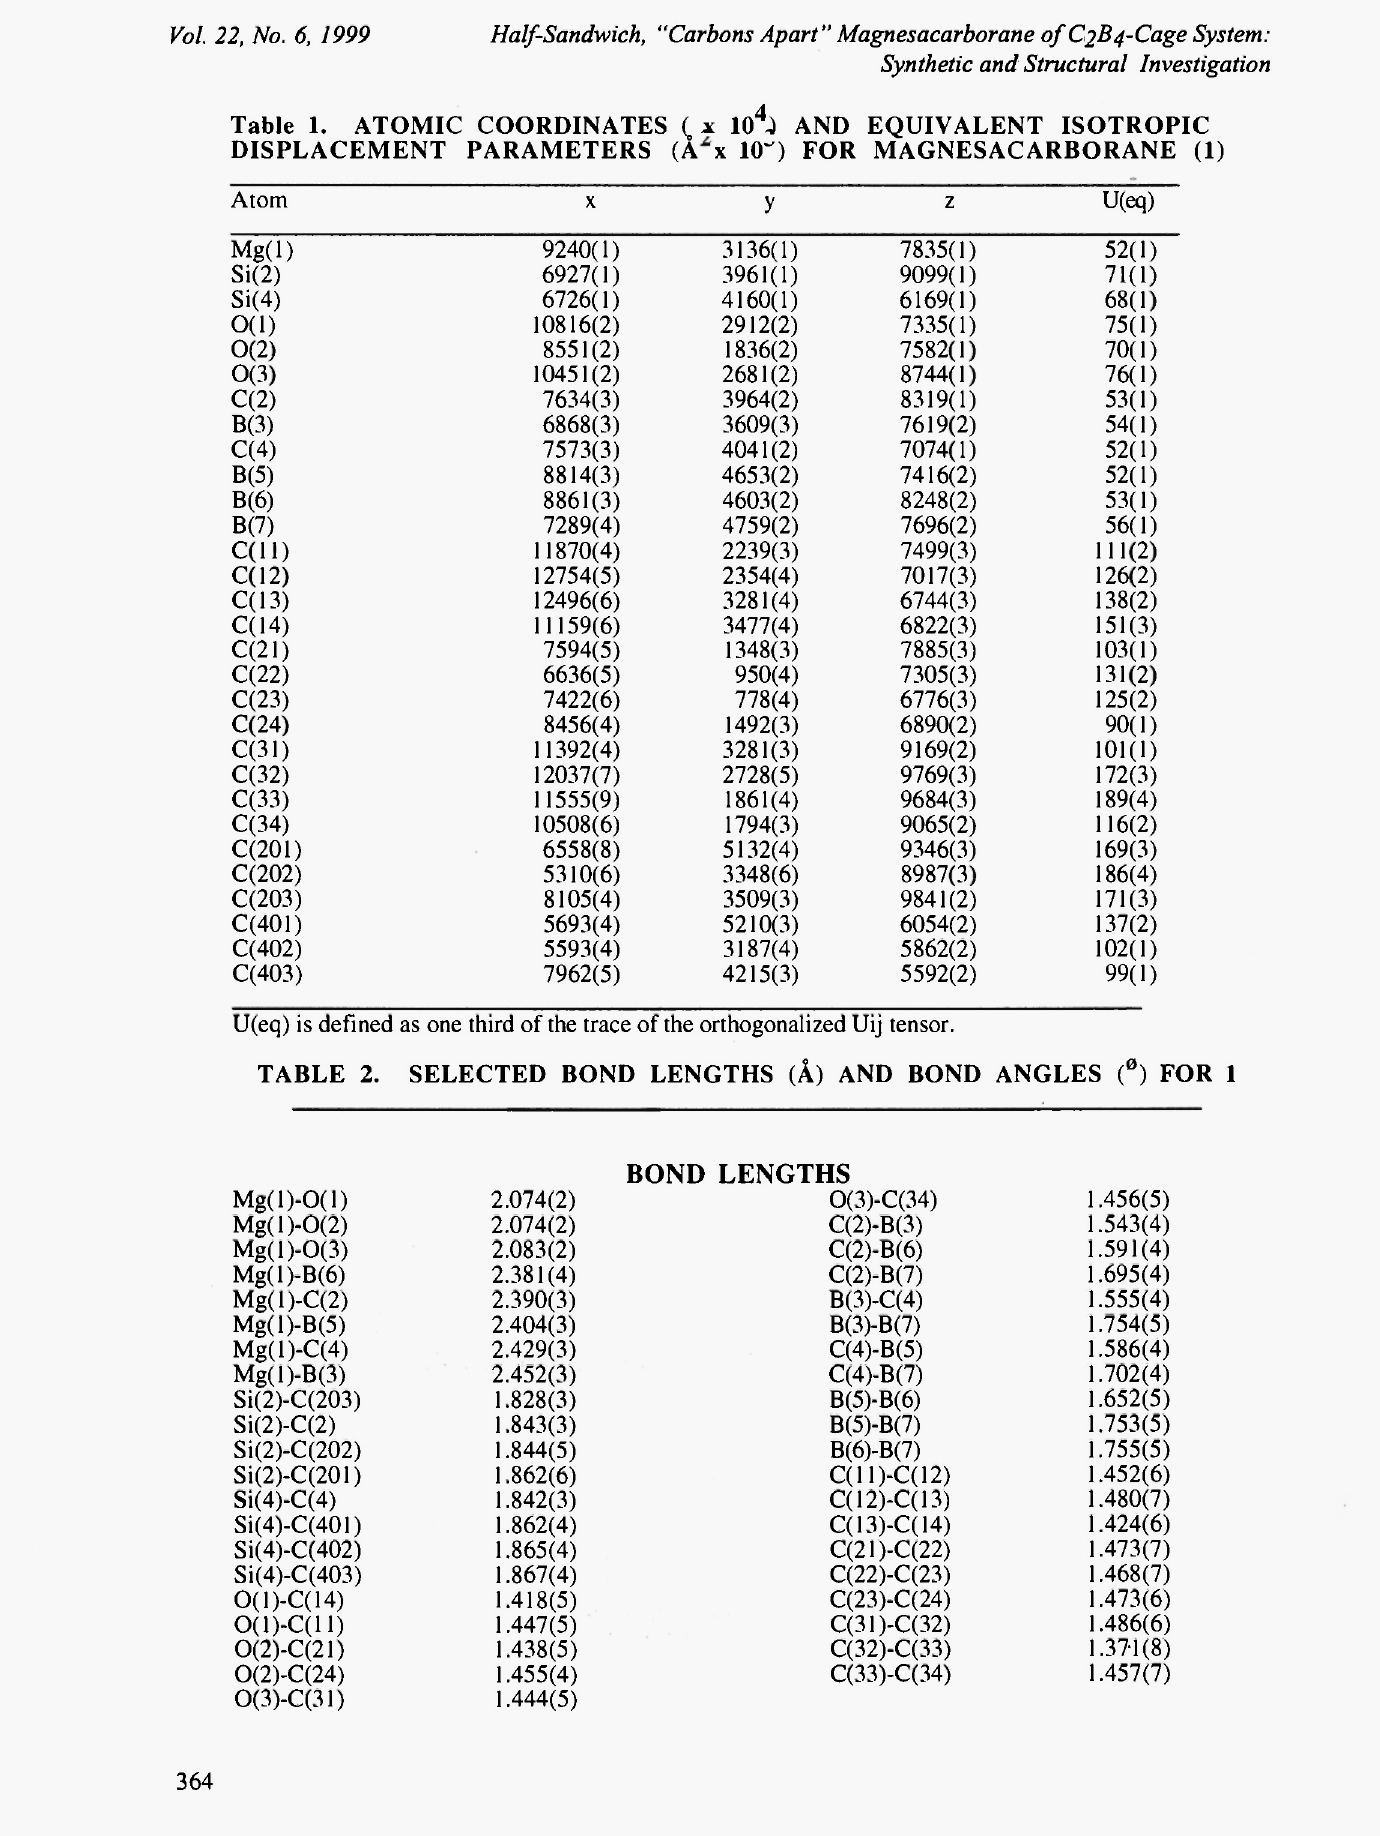
SELECTED BOND LENGTHS (Ä) AND BOND ANGLES ( 0 ) FOR